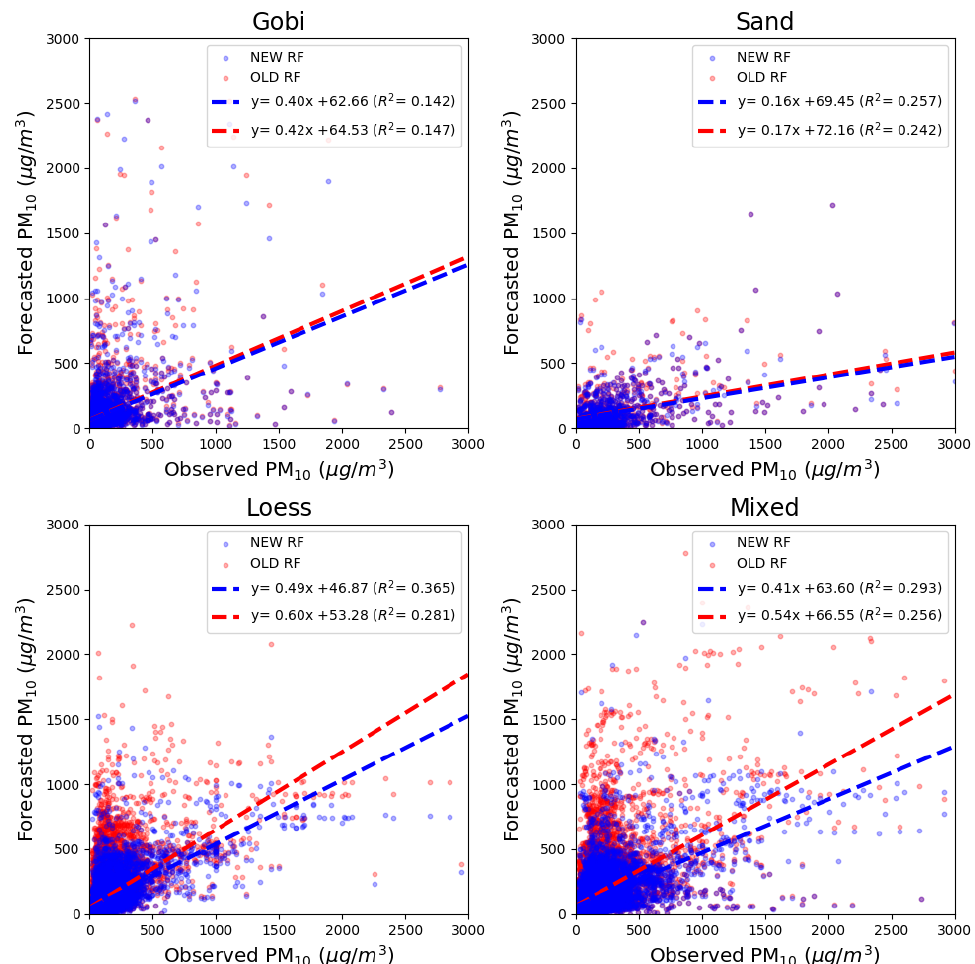
Figure 6. Scatter plot and linear regression lines of the observed PM 10 and 24 h forecasted PM 10 from OLD_RF and NEW_RF experiments in each Asian dust source region, namely, Gobi, sand, loess, and mixed.